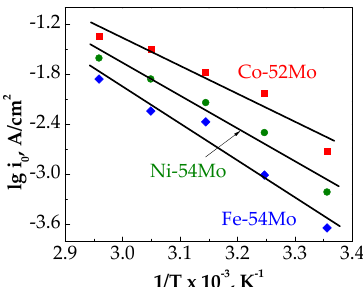
Figure 6. Arrhenius plots for Ni–54 Mo, Co–52 Mo and Fe–54 Mo electrocatalysts (composition is given in at.%).